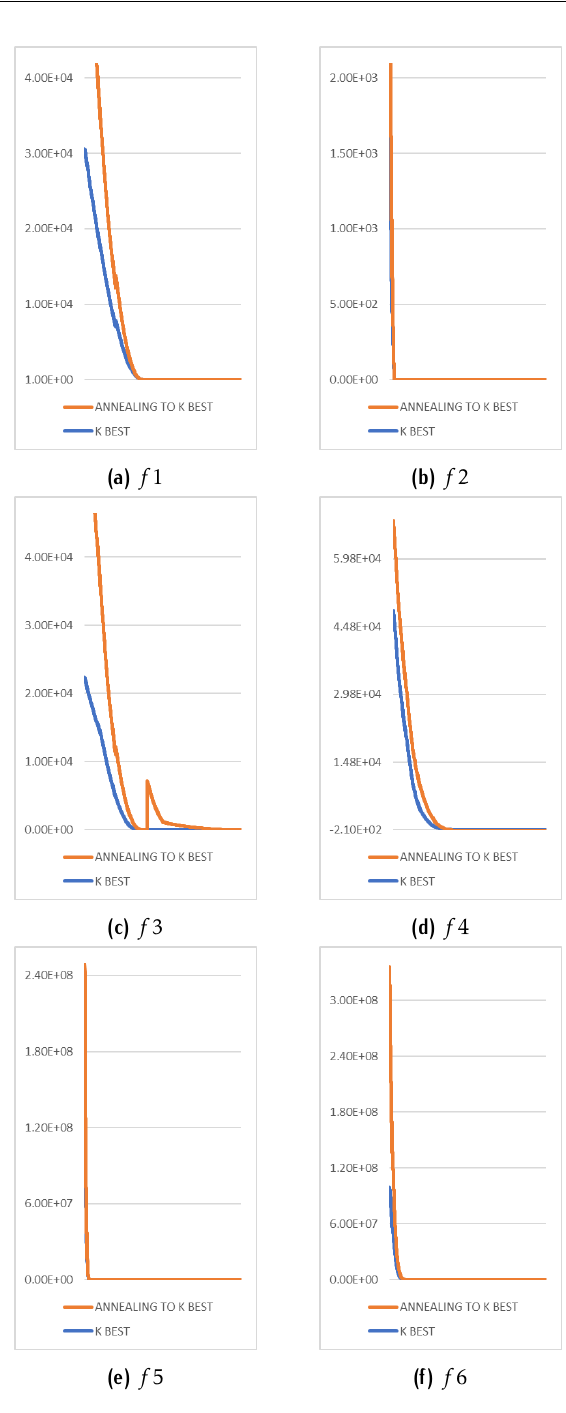
Figure 2. Convergence curves of the benchmark functions